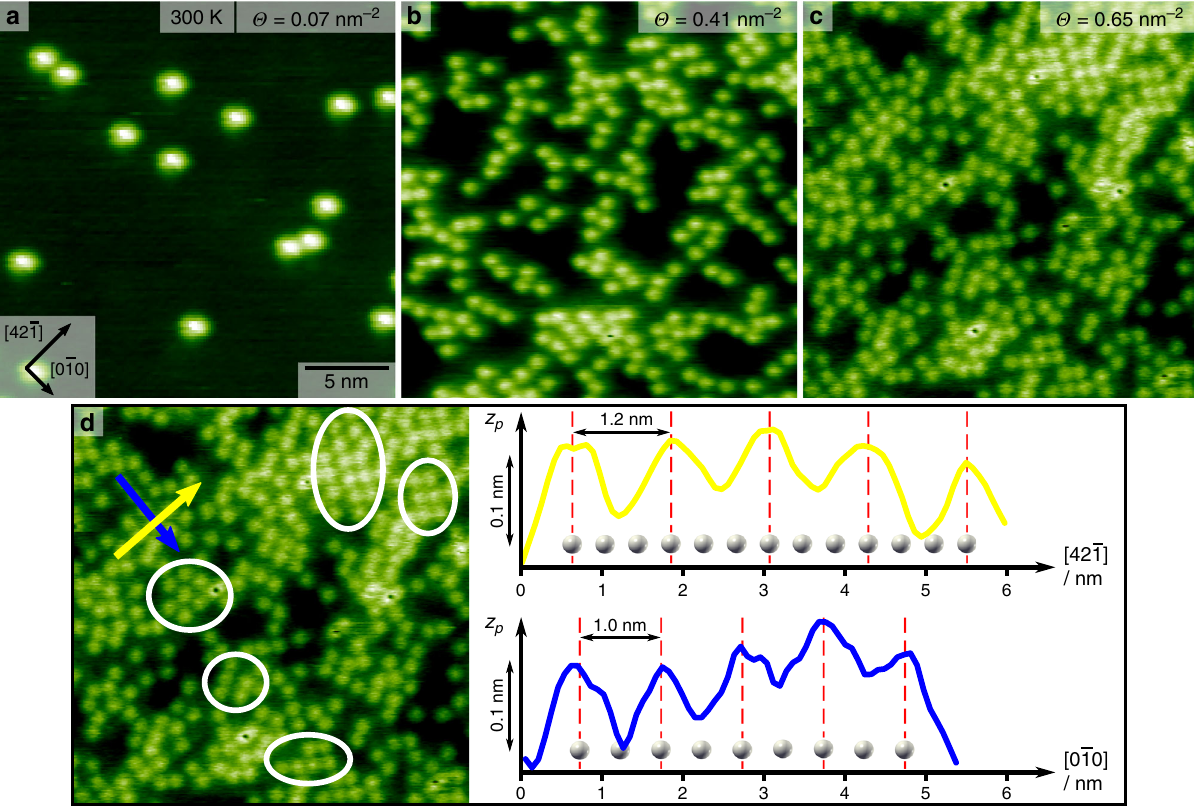
Fig. 2 AFM image of MoMo molecules on calcite (10.4) as a function of coverage. a At a low coverage of 0.07 molecules per nm 2 , single molecules are obtained. b Upon increasing the coverage to 0.41 molecules per nm 2 , areas with higher molecule density are seen, however no ordered inner structure is visible. c At a high coverage of 0.65 molecules per nm 2 , partly ordered domains can be observed. d Some ordered domains are marked with a white circle. (cid:1) (cid:3) (cid:1) (cid:3) Height pro fi les along the 42 (cid:1) 1 (yellow arrow) and 0 (cid:1) 10 (blue arrow) direction are displayed. The white calcium ions indicate the substrate lattice. MoMo adsorbs exclusively on identical adsorption